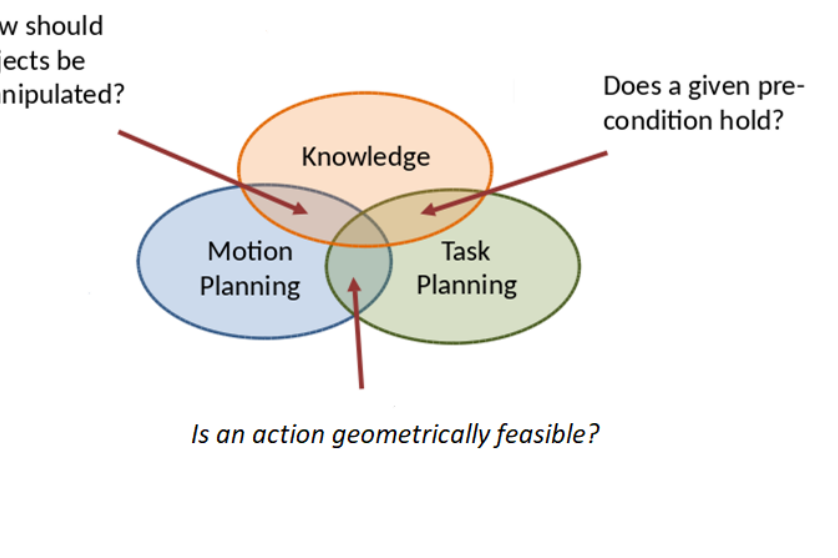
Figure 2. Knowledge-based reasoning for task and motion planning